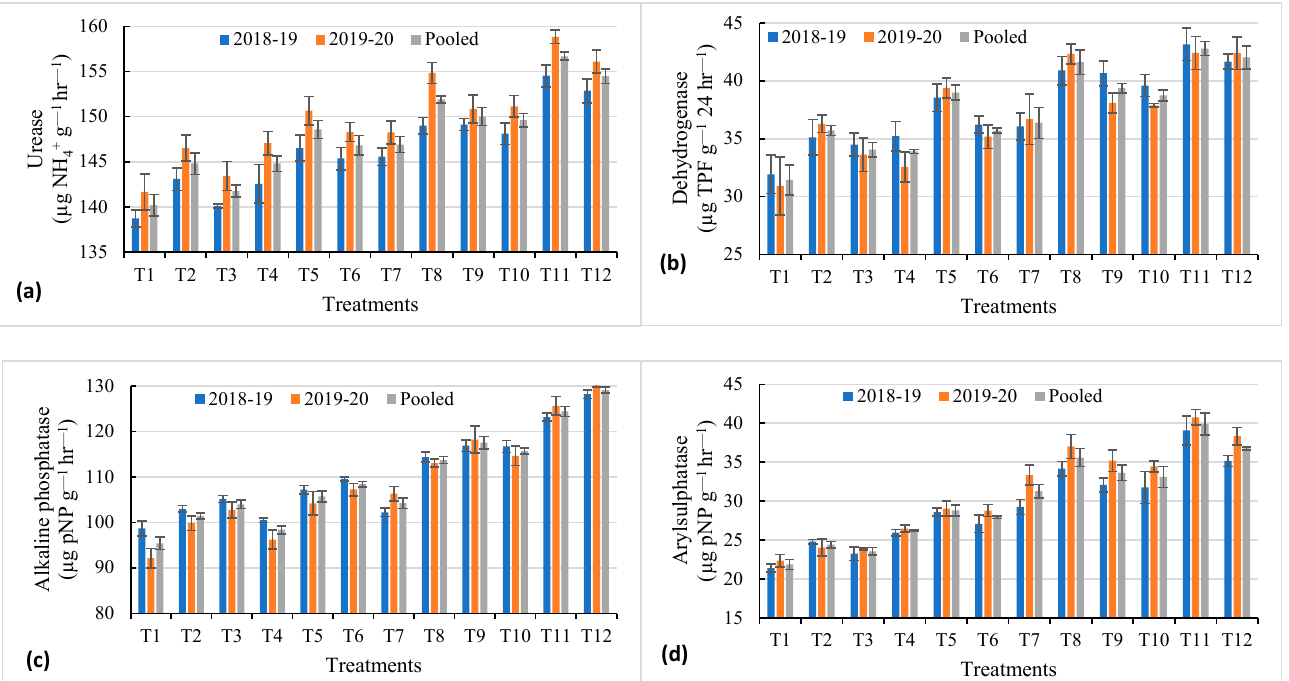
Figure 2. Soil enzymatic activities as influenced by the seed biopriming and varied levels of S fertilization in mustard. ( a ) Urease activity ( b ) Dehydrogenase activity ( c ) Alkaline phosphatase activity ( d ) Arylsulphatase activity. Error bars indicate mean ± SE ( n = 3). Treatments: T 1 —0 kg S ha −